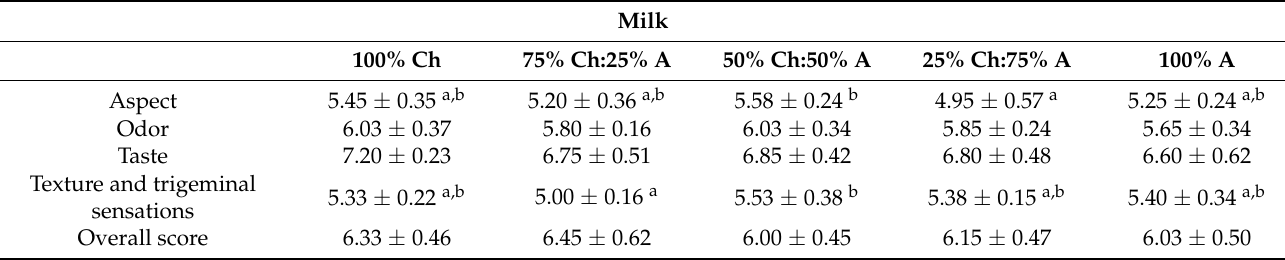
Table 6. Average values assigned by tasting panel of consumers for various sensory attributes linked to appearance, aroma, texture and flavor, and an overall evaluation for Zamorano cheese made with milk from Churra (Ch) and Assaf (A) breed after 240 days’